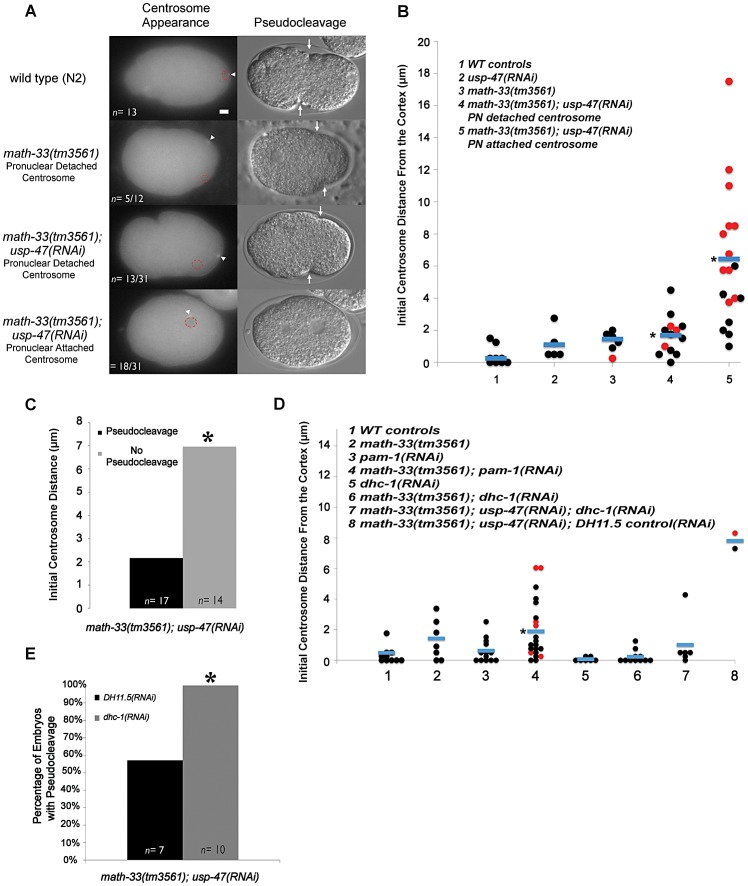
Deubiquitylases regulate the position of the centrosome in early one-cell embryos.(A) Micrographs showing tubulin::GFP in embryos at the time the centrosome was first detected. Centrosomes are marked with a white arrowhead and the position of the paternal pronucleus is indicated by red dotted circles. The DIC micrograph column shows representative embryos of the same genotypes at the time of pseudocleavage (an indirect indicator of the extent of myosin clearing). The white arrows indicate the location of pseudocleavage furrows. (B) Distance in micrometers of the centrosome from the embryo cortex at the time of earliest detection for the indicated genotypes. Each data point represents a single embryo. Black dots are embryos that had normal or weak pseudocleavage, red dots are embryos that displayed no pseudocleavage. Blue bars mark the mean distance. The asterisk indicates a significant difference from WT controls, p<0.01, by Student's t-test. (C) The number of embryos lacking pseudocleavage increases as centrosome distance from the cortex increases. Embryos were pooled from five RNAi experiment replicates. Differences were statistically significant according to a Student's t-test, p<0.01. (D) The distance of the centrosome from the cortex measured in the indicated genetic backgrounds. p<0.01 for column 4 compared to WT distances from multiple experiments, but p = 0.156 for column 4 compared to math-33(tm3561) in multiple experiments. (E) A single experiment examining absence of pseudocleavage resulting from depletion of DUBs. The absence of pseudocleavage phenotype is completely suppressed by dhc-1(RNAi), p<0.05. Scale bar represents 5 µm.